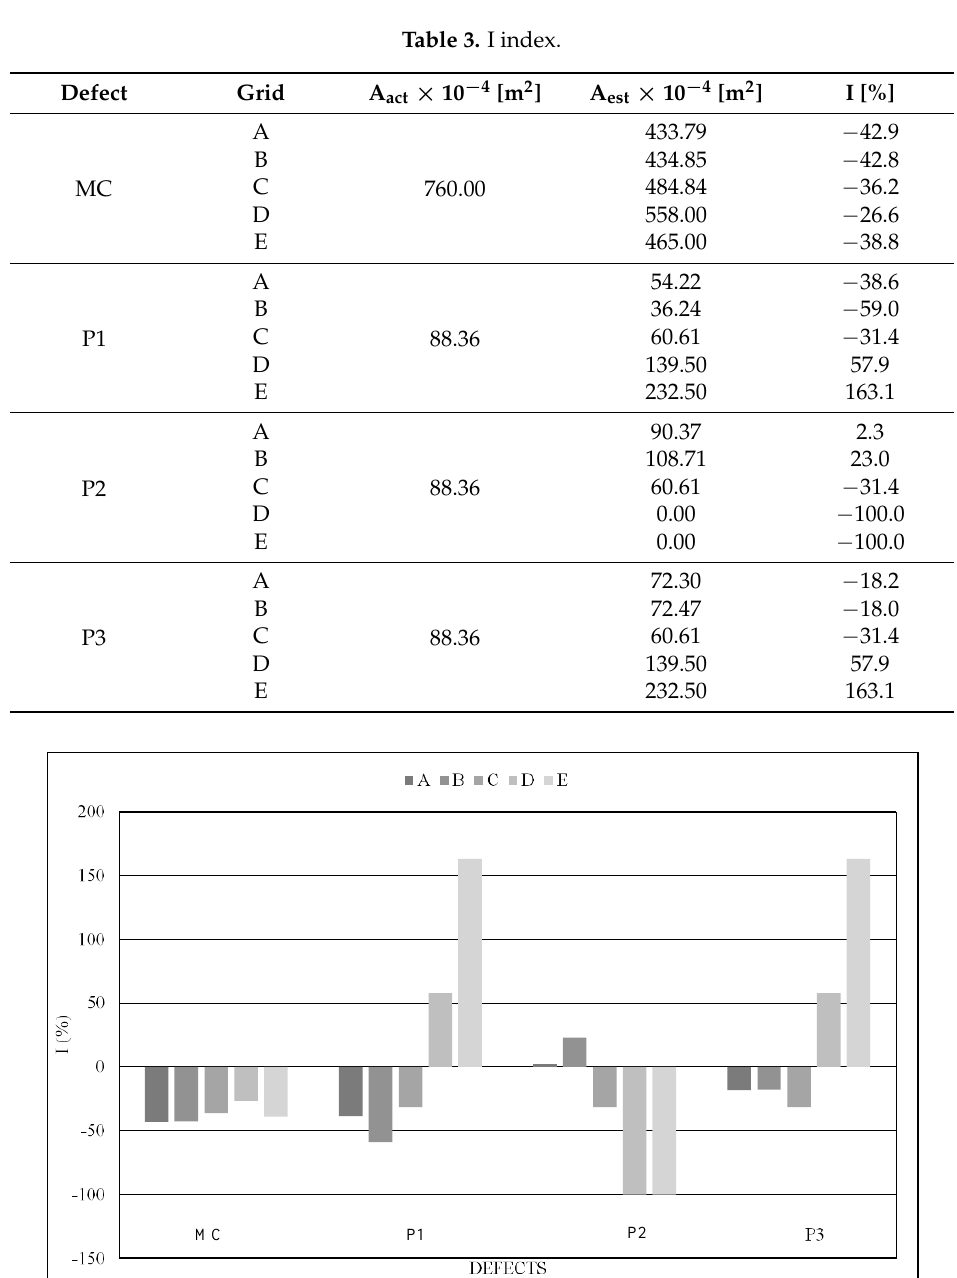
Figure 13. I index: comparison between the accuracy of measurement grids.